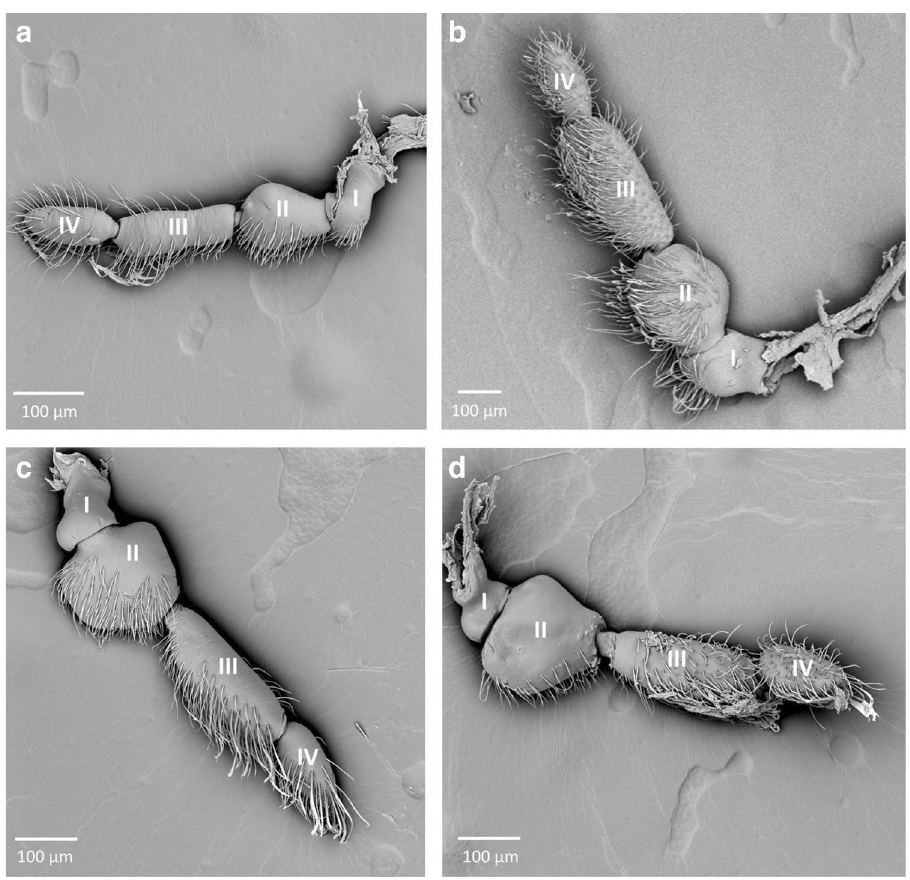
Figure 4. The antennae of Naucorinae; ( a ) Naucoris scutellaris , ( b ) Naucoris cimicoides , ( c ) Pelocoris femoratus , ( d ) Pelocoris poeyi ; I–IV—numbers of